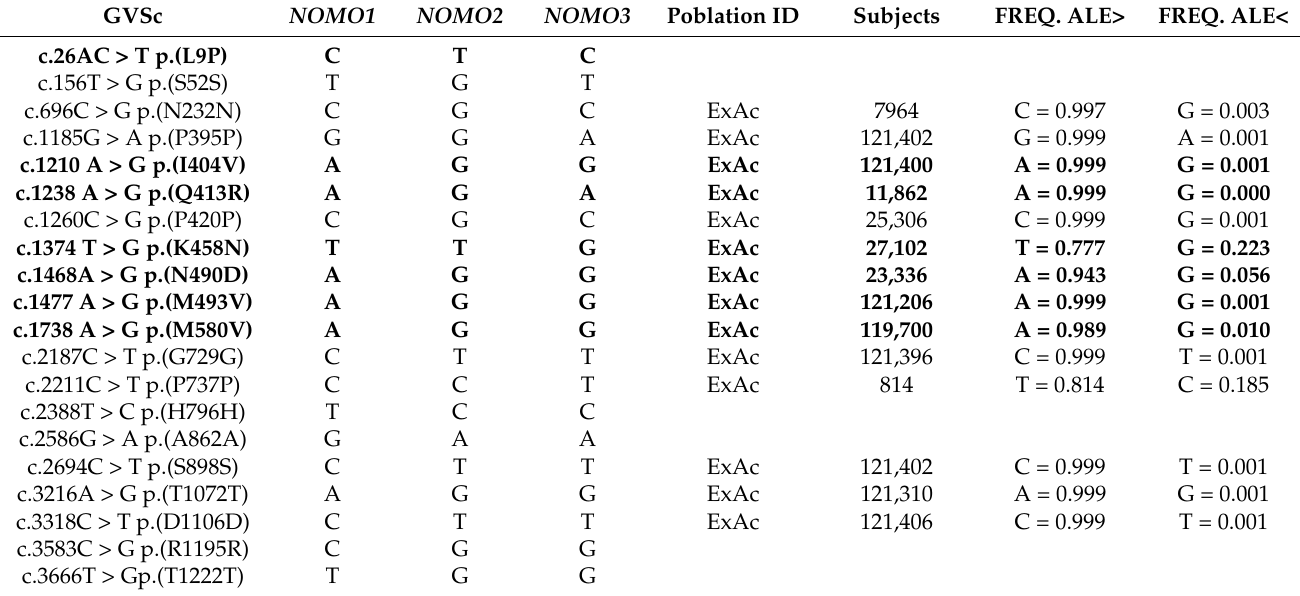
Table 1. Allele frequency of nucleotides that differ among the reported NOMO1, NOMO2, and NOMO3 genes. Missense mutations are marked in bold.